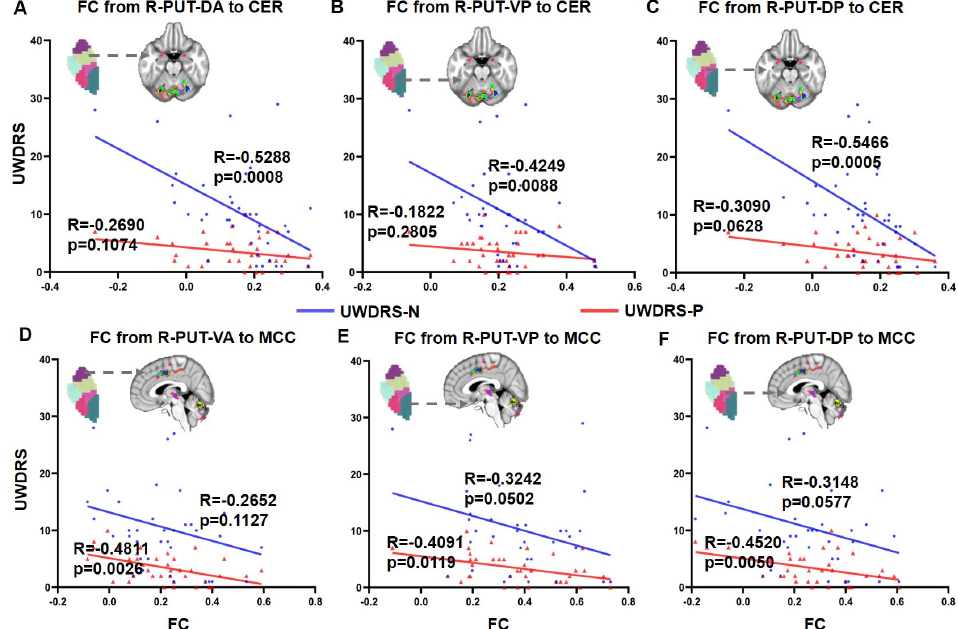
Figure 4. Correlation between FC from the putamen to cerebellum or middle cingulate cortex and subscales of UWDRS. ( A ) Correlation between FC from R-PUT-DA to CER and subscales of UWDRS; ( B ) Correlation between FC from R-PUT-VP to CER and subscales of UWDRS; ( C ) Correlation between FC from R-PUT-DP to CER and subscales of UWDRS; ( D ) Correlation between FC from R-PUT-VA to MCC and subscales of UWDRS; ( E ) Correlation between FC from R-PUT-VP to MCC and subscales of UWDRS; ( F ) Correlation between FC from R-PUT-DP to MCC and subscales of UWDRS; Abbreviations: FC, functional connectivity; CER, cerebellum; MCC, middle cingulate cortex; PUT, putamen; DA, dorsal anterior; VP, ventral posterior; DP, right dorsal posterior; VA, ventral anterior; L, left; R, right; UWDRS, United Wilson’s Disease Rating Scale; UWDRS-N, neurological subscale in UWDRS; UWDRS-P, psychiatric subscale in UWDRS.